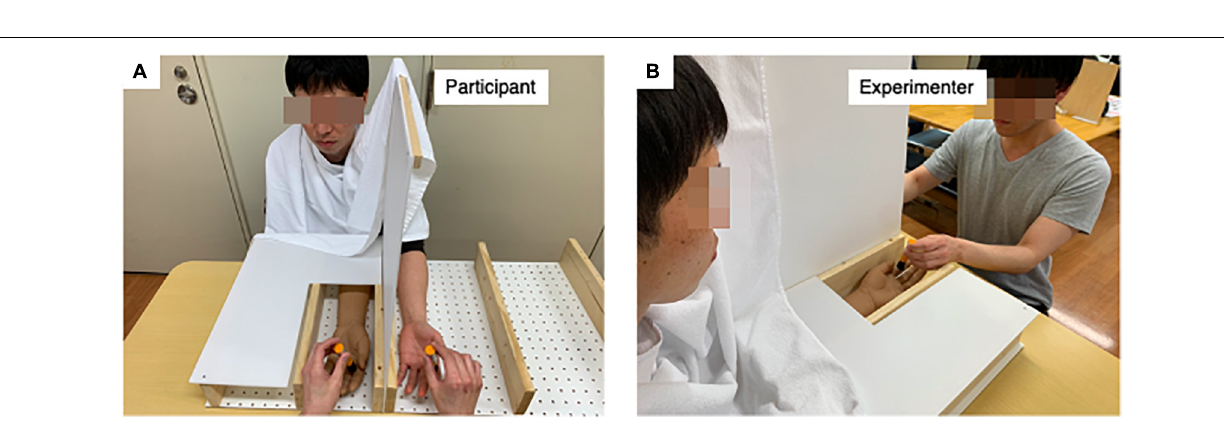
Frontiers in Systems Neuroscience |